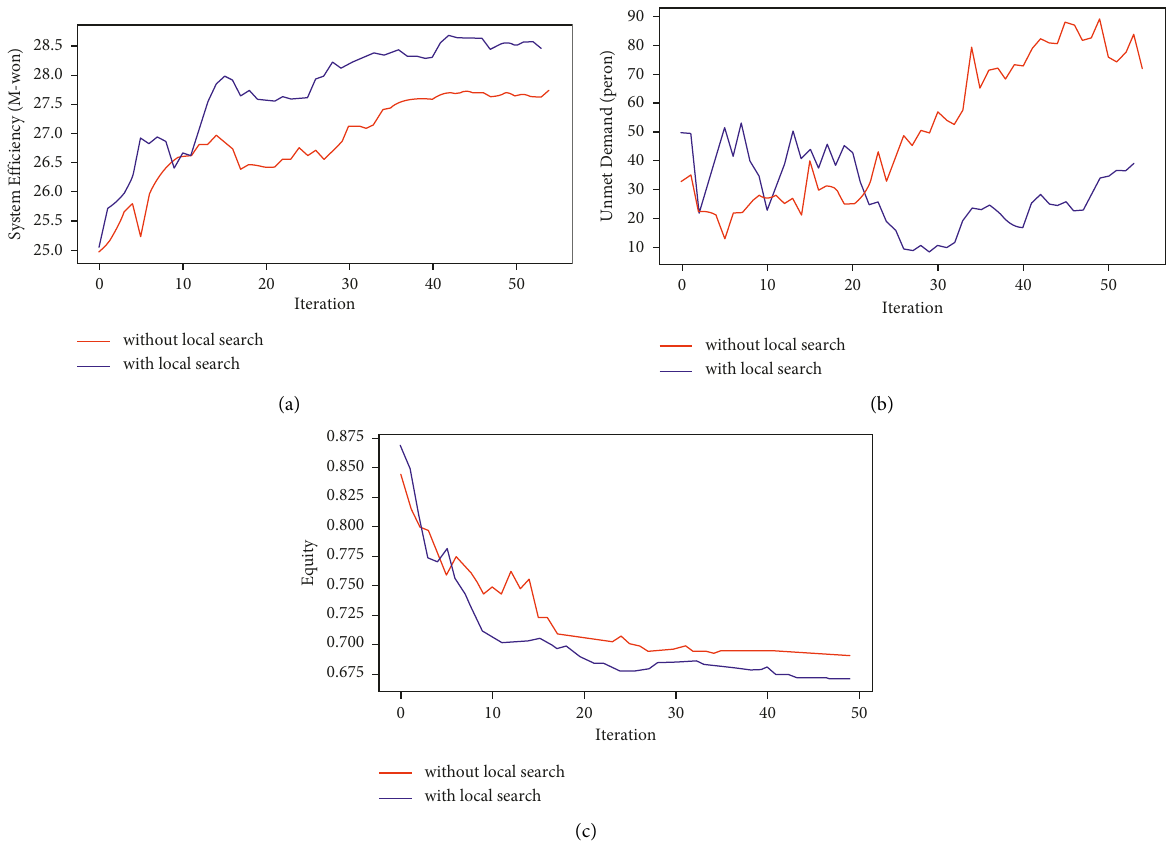
Figure 11: Objective Function values by iteration with and without neighborhood local search, (a) System efficiency, (b) Unmet demand, (c)